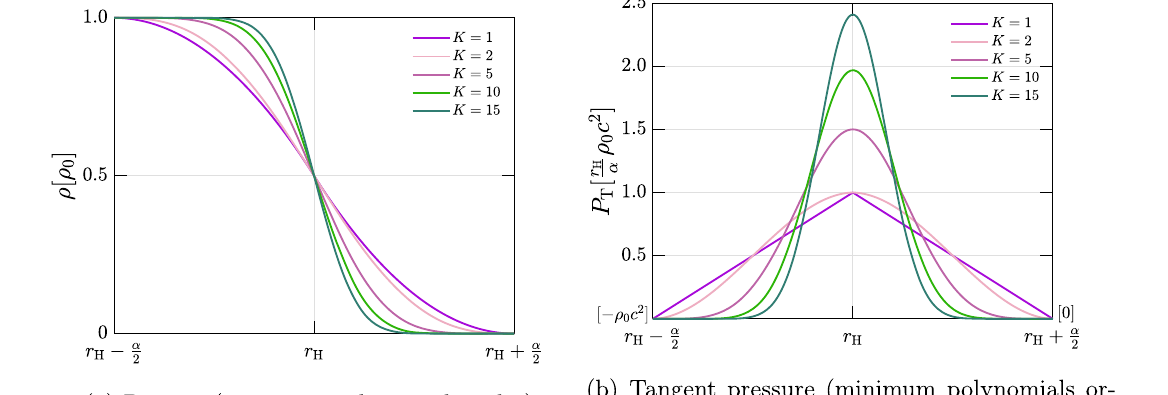
continuous. We observe that density variation is constrained for large K within much smaller region than